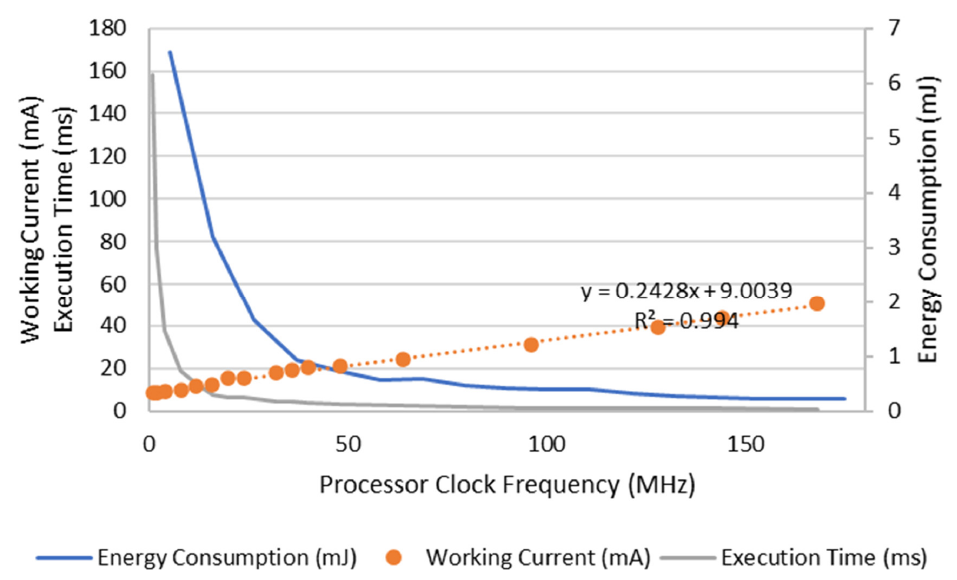
Figure 8. The relation between the energy consumption and the processor frequency of the entire core board.